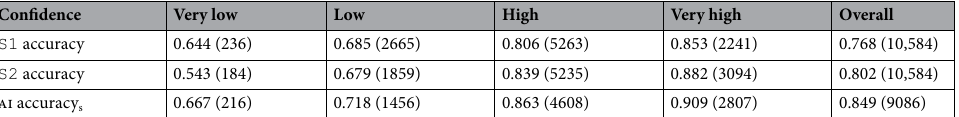
Table 3. Proportions and sample sizes of the correct human diagnosis in S1 , S2 and the ai perceived correct diagnosis, against different human confidence levels and the ai perceived confidence levels, respectively. Following the standard in the field, accuracy s does not consider wrong lesions where ai opinion was perceived as “uncertain” or was “not noticed”. Evaluations of the confidence of the ai were asked only when the opinion was “Adenoma” or “Non-Adenoma”.